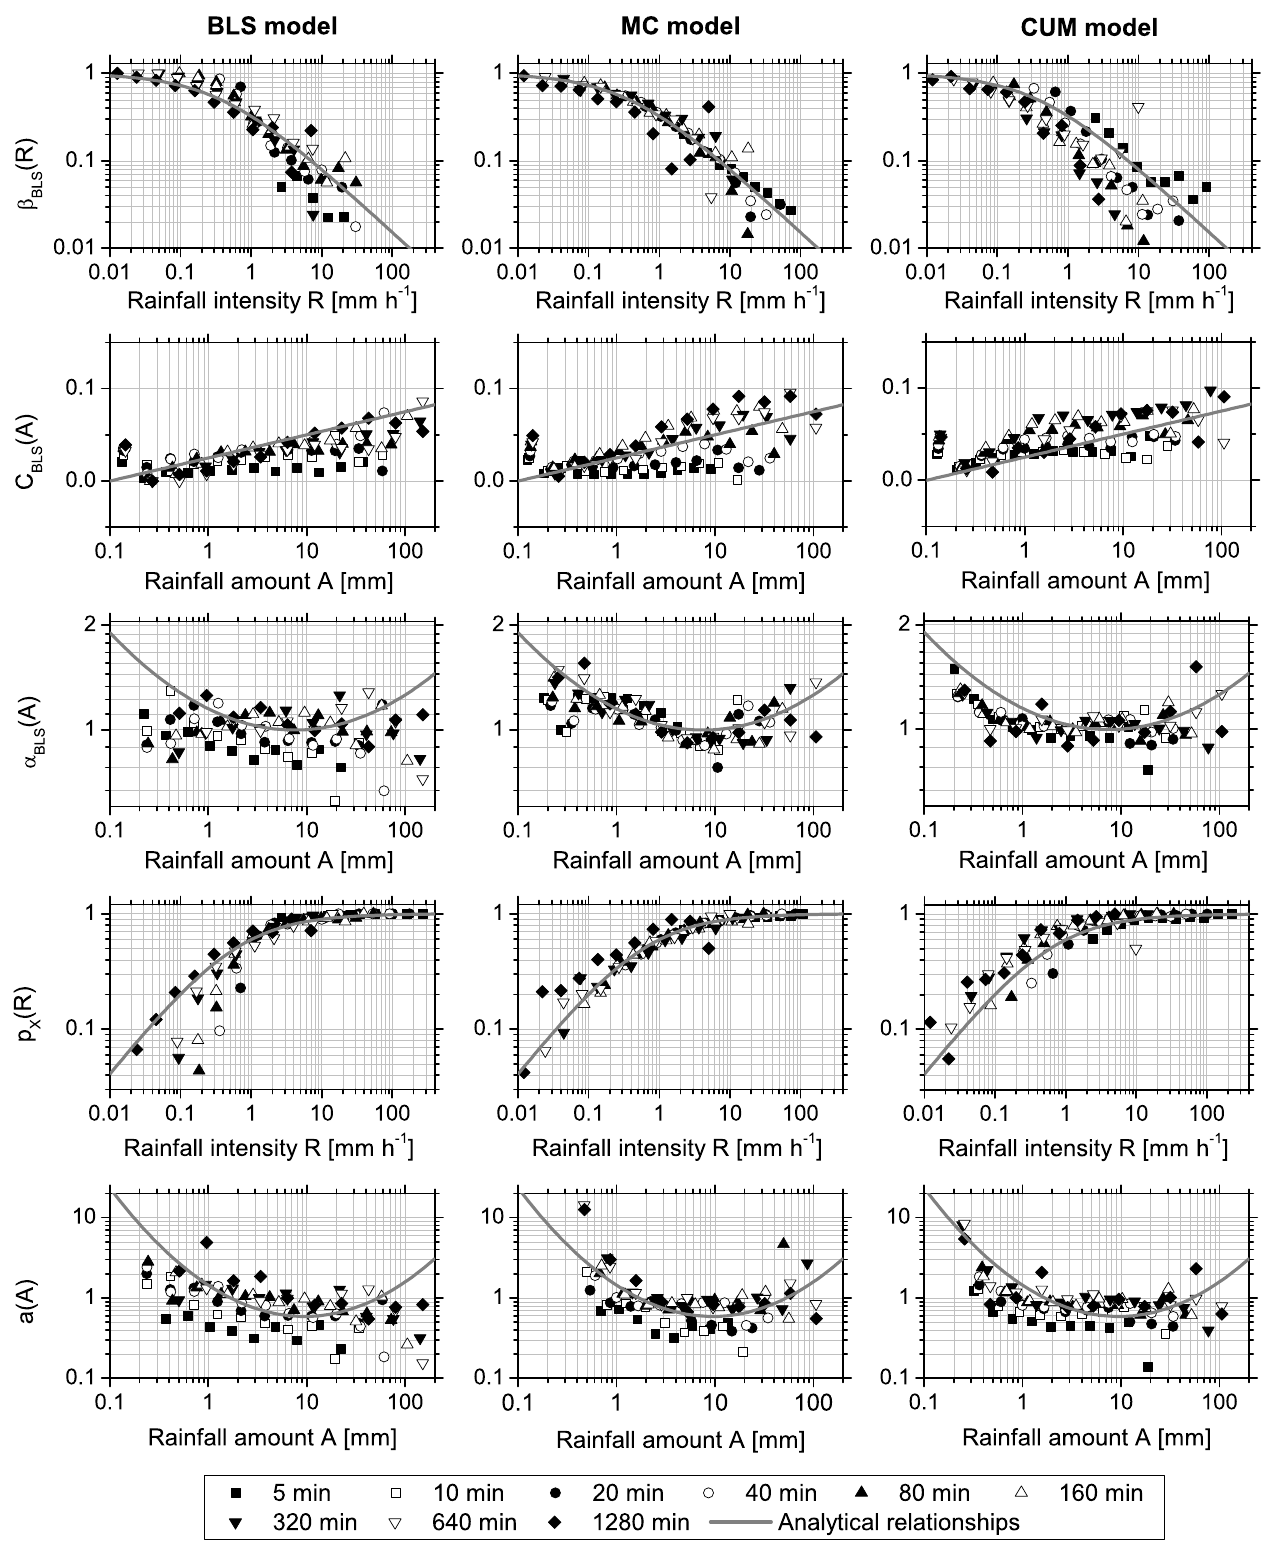
Fig. 4. Relationships between models’ parameters and rainfall intensity (or amount) for three representative series simulated by BLS, MC, and CUM